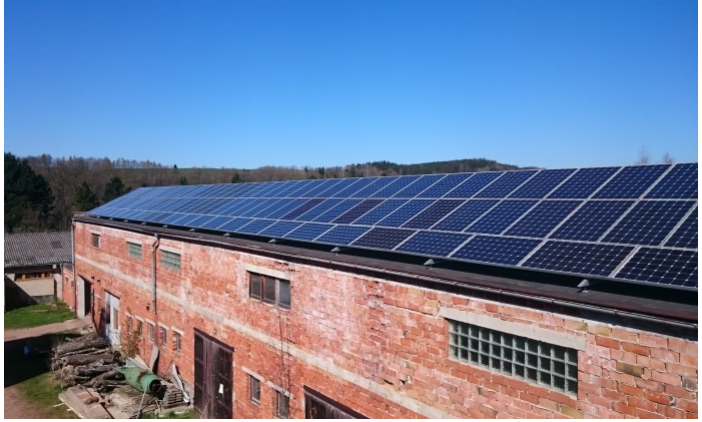
Figure 15. Selected part of the 100 kWp PV plant [27].